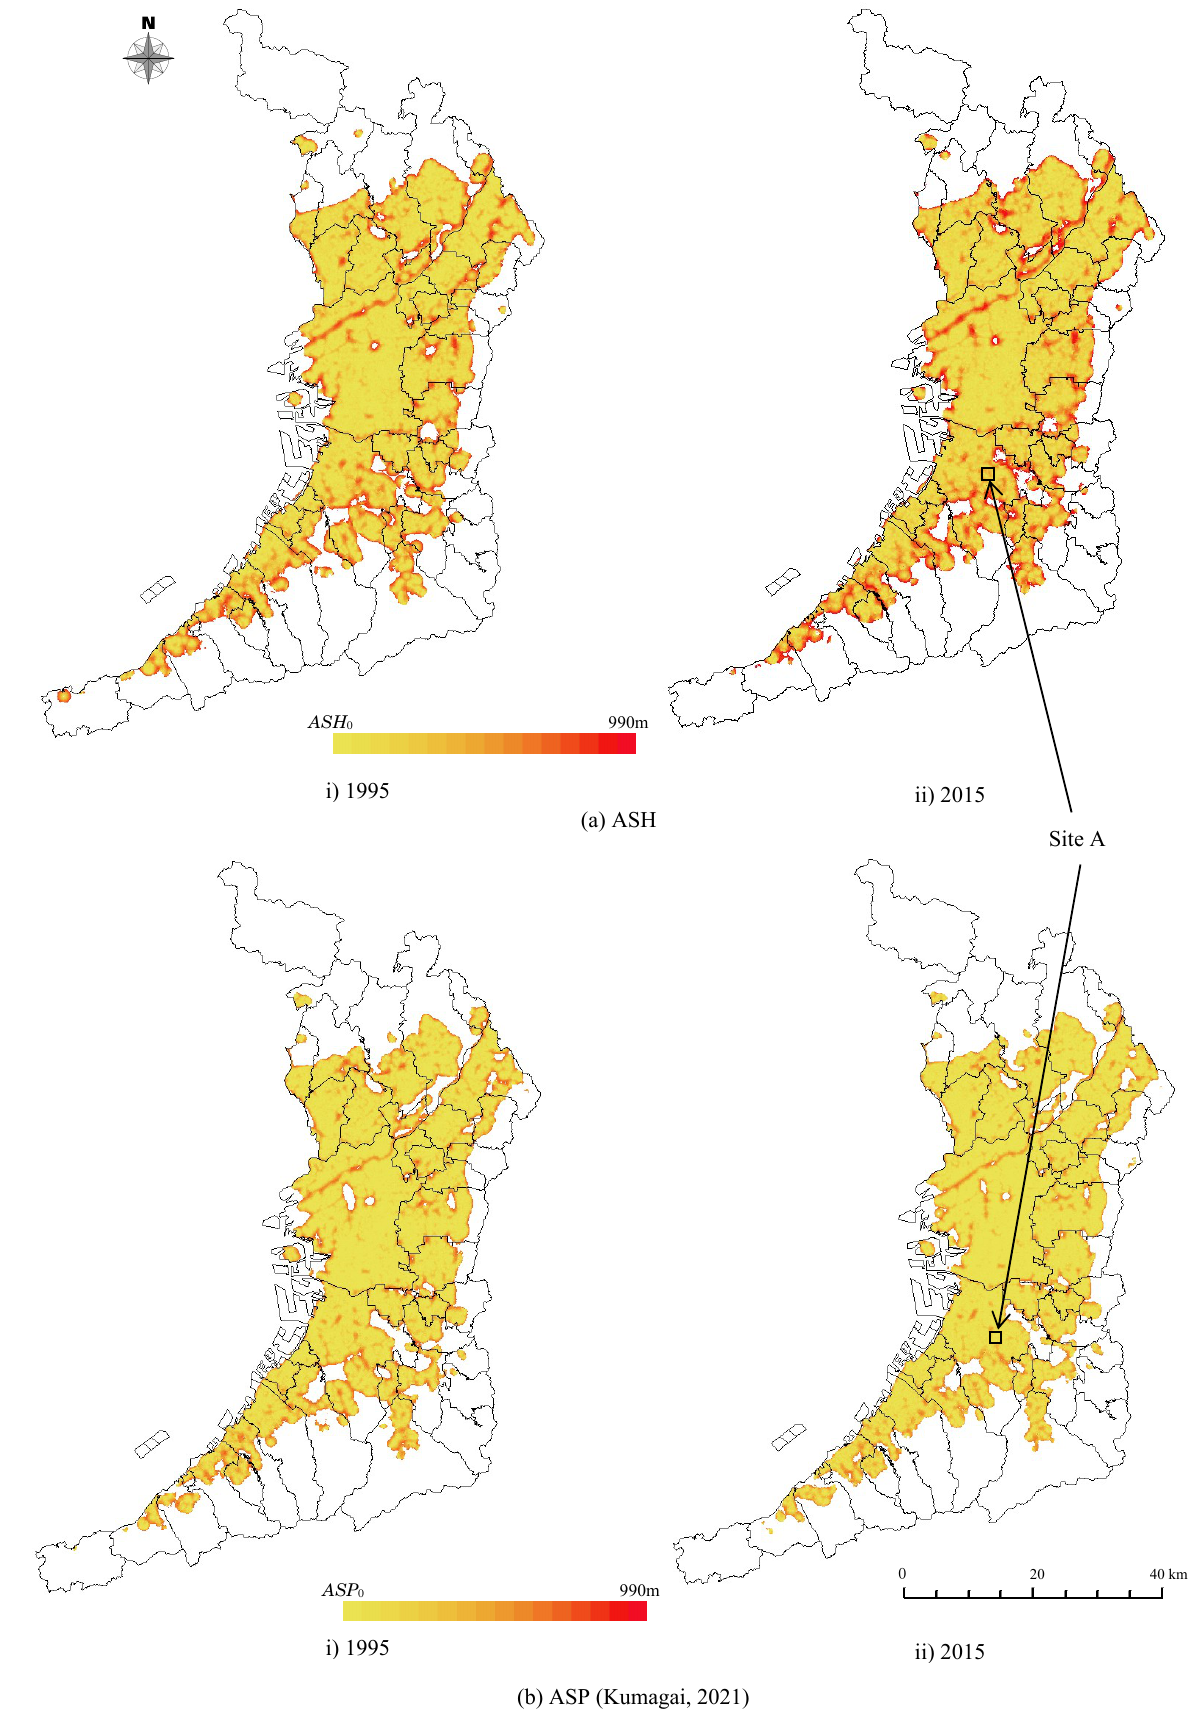
Figure 7 . Results of the spatial analysis: distributions of ASH and